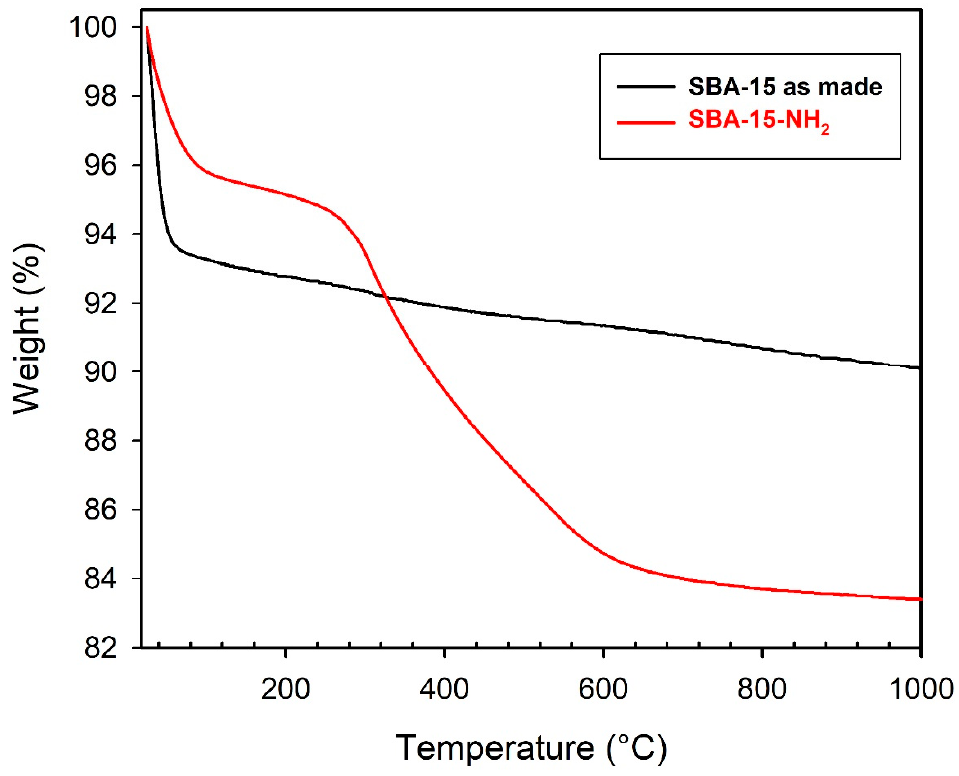
Figure A2. TGA profiles of SBA-15 and SBA-15-NH 2.